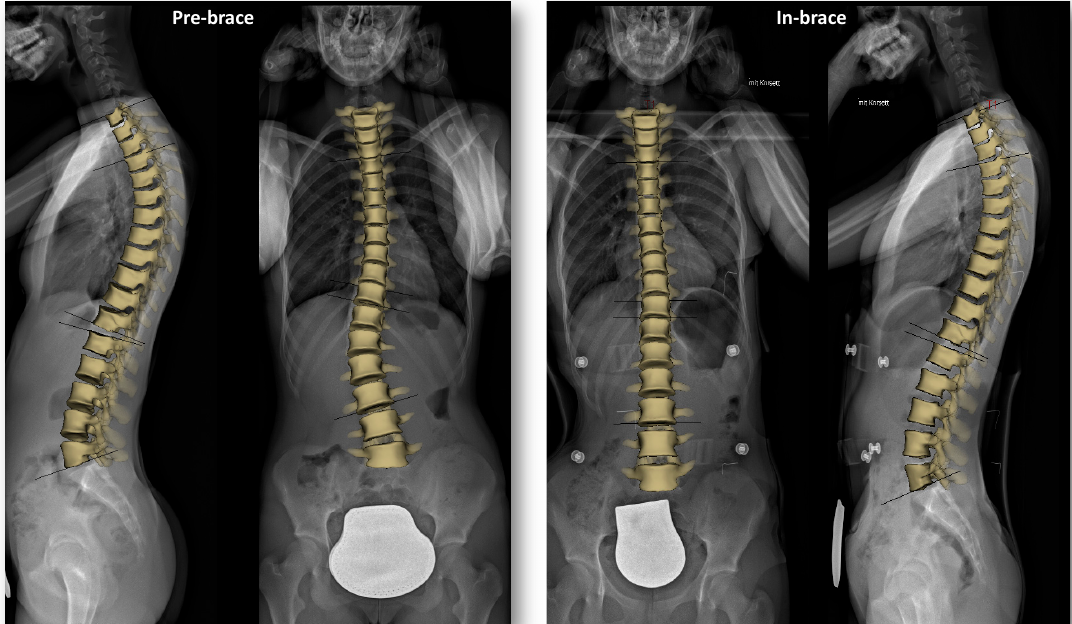
Figure 7. A 3D spinal reconstruction superimposed on biplanar stereoradiographs for a 14-year-old patient undergoing bracing treatment. This figure depicts the coronal correction of the thoracolumbar scoliotic curve.